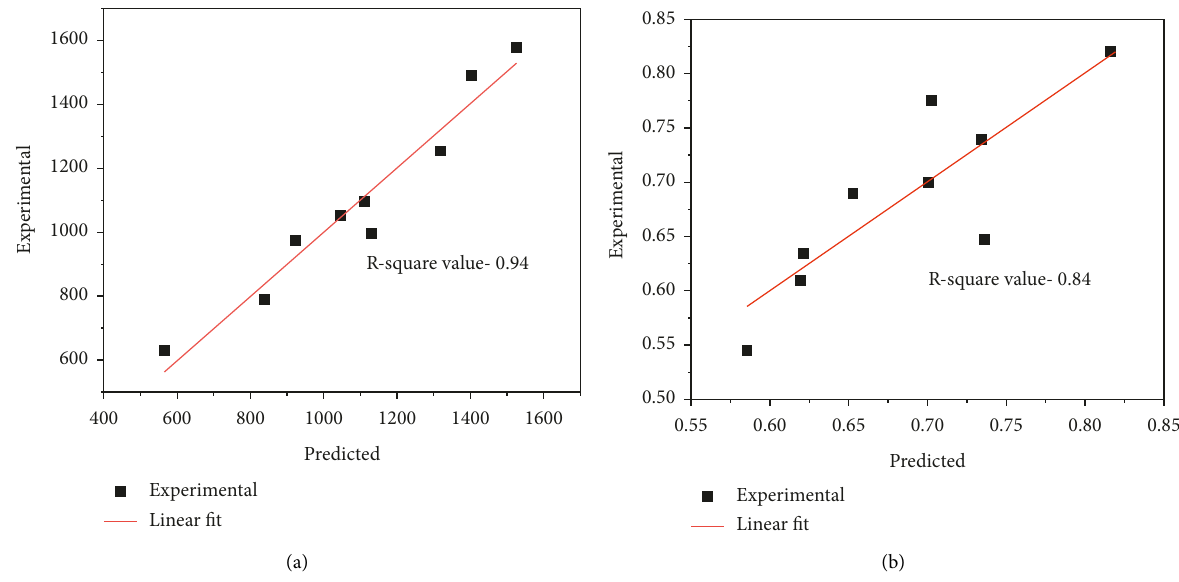
Figure 8: R -square fit: (a) material removal rate (mm 3 /min) and (b) surface roughness ( μ m).